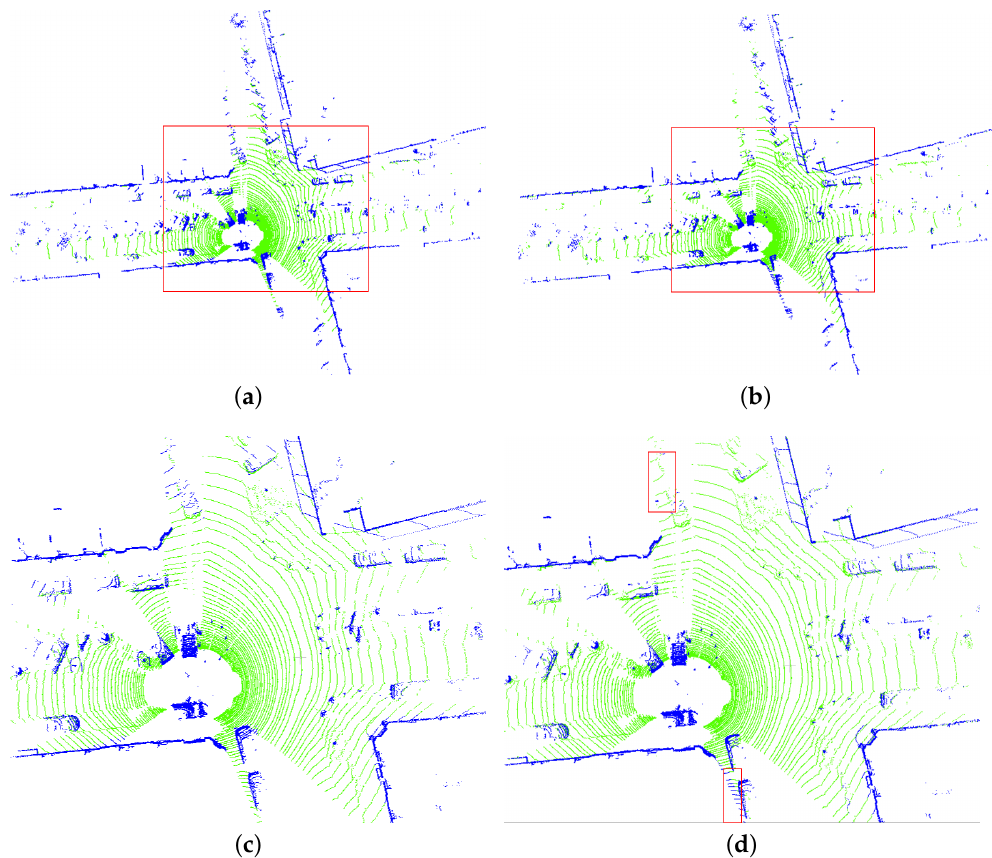
Figure 6. The result of the proposed method. The red box area in ( d ) is classified incorrectly. ( a ) The point cloud manually labeled. ( b ) The point cloud processed by the proposed method. ( c ) The red box area in ( a ). ( d ) The red box area in ( b